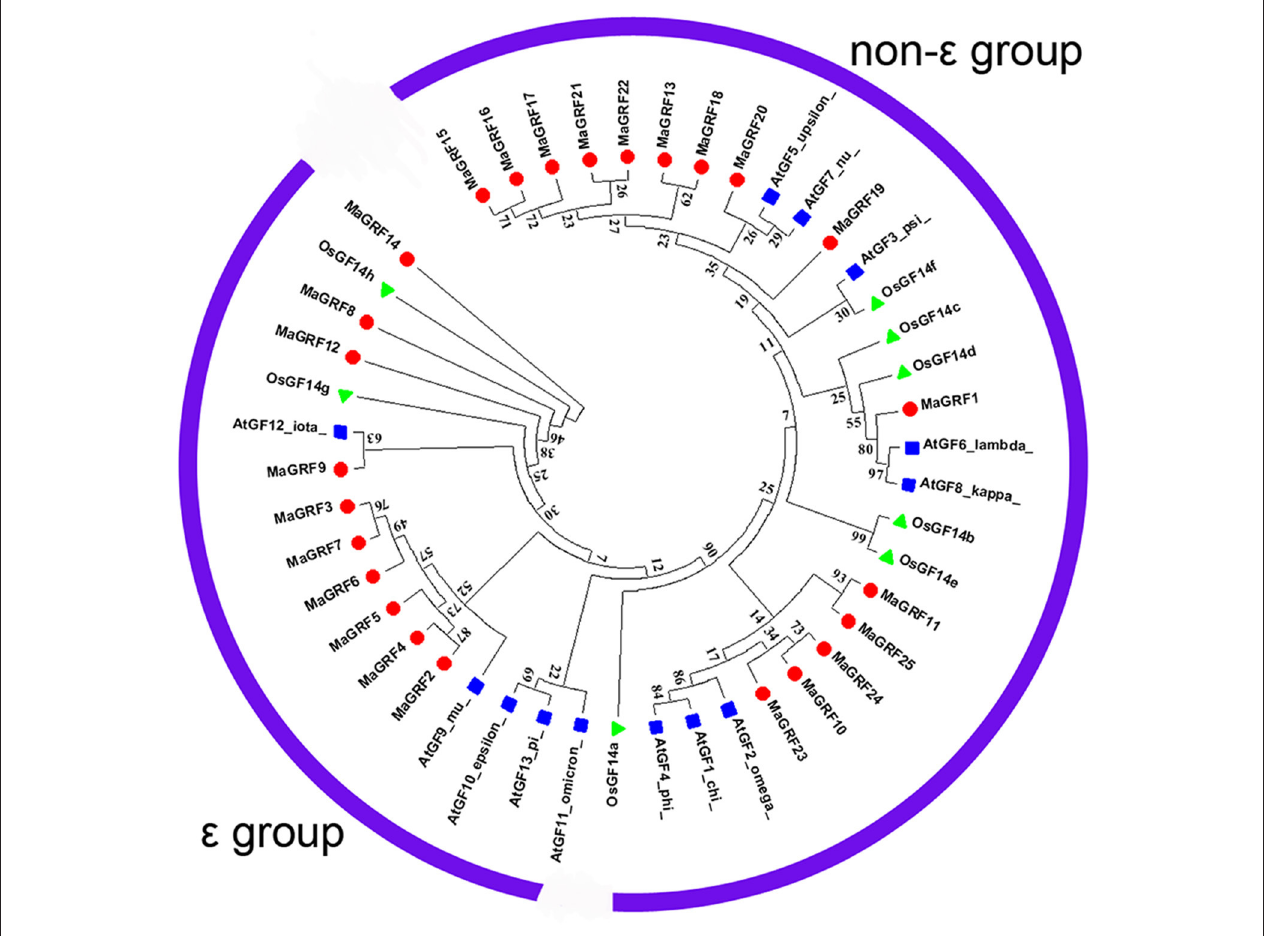
FIGURE 2 | Phylogenetic analysis of 14-3-3s from Arabidopsis , rice, and banana using Neighbor-joining method. The Phylogenetic tree was constructed by using ClustalX 2.0 and MEGA5.0 software with pair-wise deletion option. Tree reliability was assessed using 1000 bootstraps replicates. The numbers indicated for each clade represent bootstrap support values given as percentages. Two groups were shown as ε group and the non- ε group. Solid round, 25 14-3-3 proteins from banana; Solid Square, 12 14-3-3 proteins from Arabidopsis ; Solid triangle, 8 14-3-3 proteins from